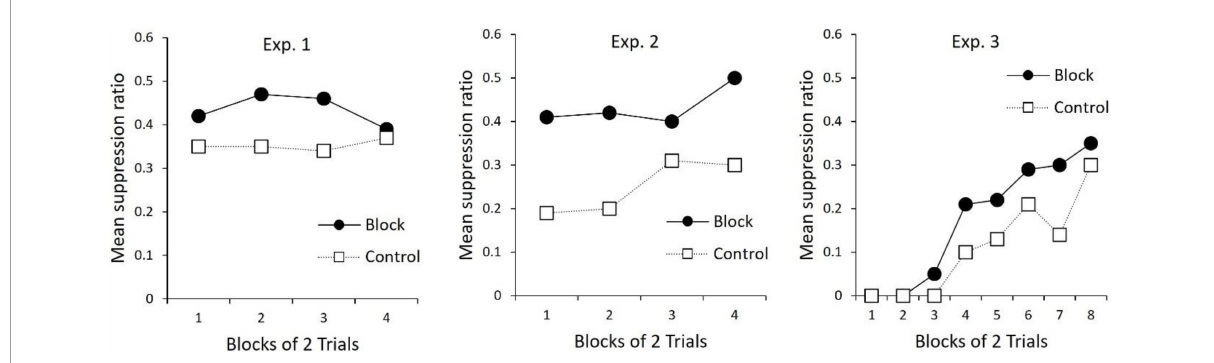
FIGURE2 Re-drawn results from Bombace (1982). All panels depict suppression to the Light during the Test phase (see Table 3 ). For Experiment 1, Bombace (1982) reports that suppression to the Light in Block was significantly less than Control on trial blocks 1–4. For Experiment 2, Bombace (1982) reports suppression to L was less for Block than Control on trial blocks 1–4. For Experiment 3, suppression in Block was less than Control on trial block 5, and over trial blocks